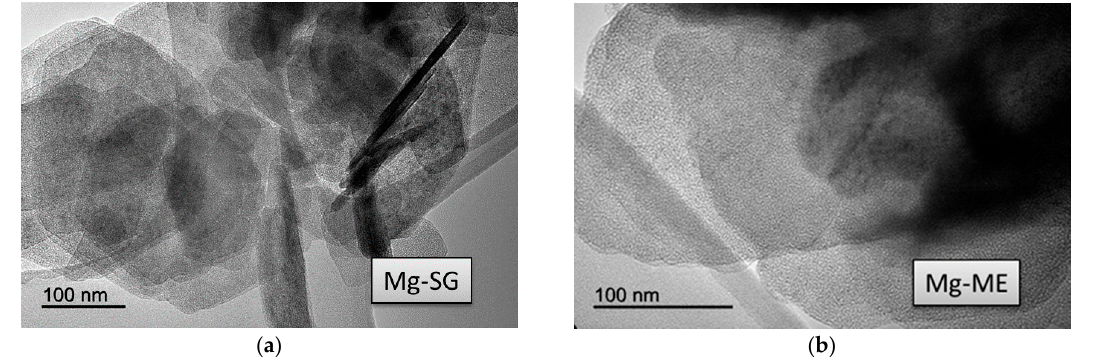
Figure 3. TEM images corresponding to pure ( a ) Zr-SG and ( b ) Zr-ME solids.